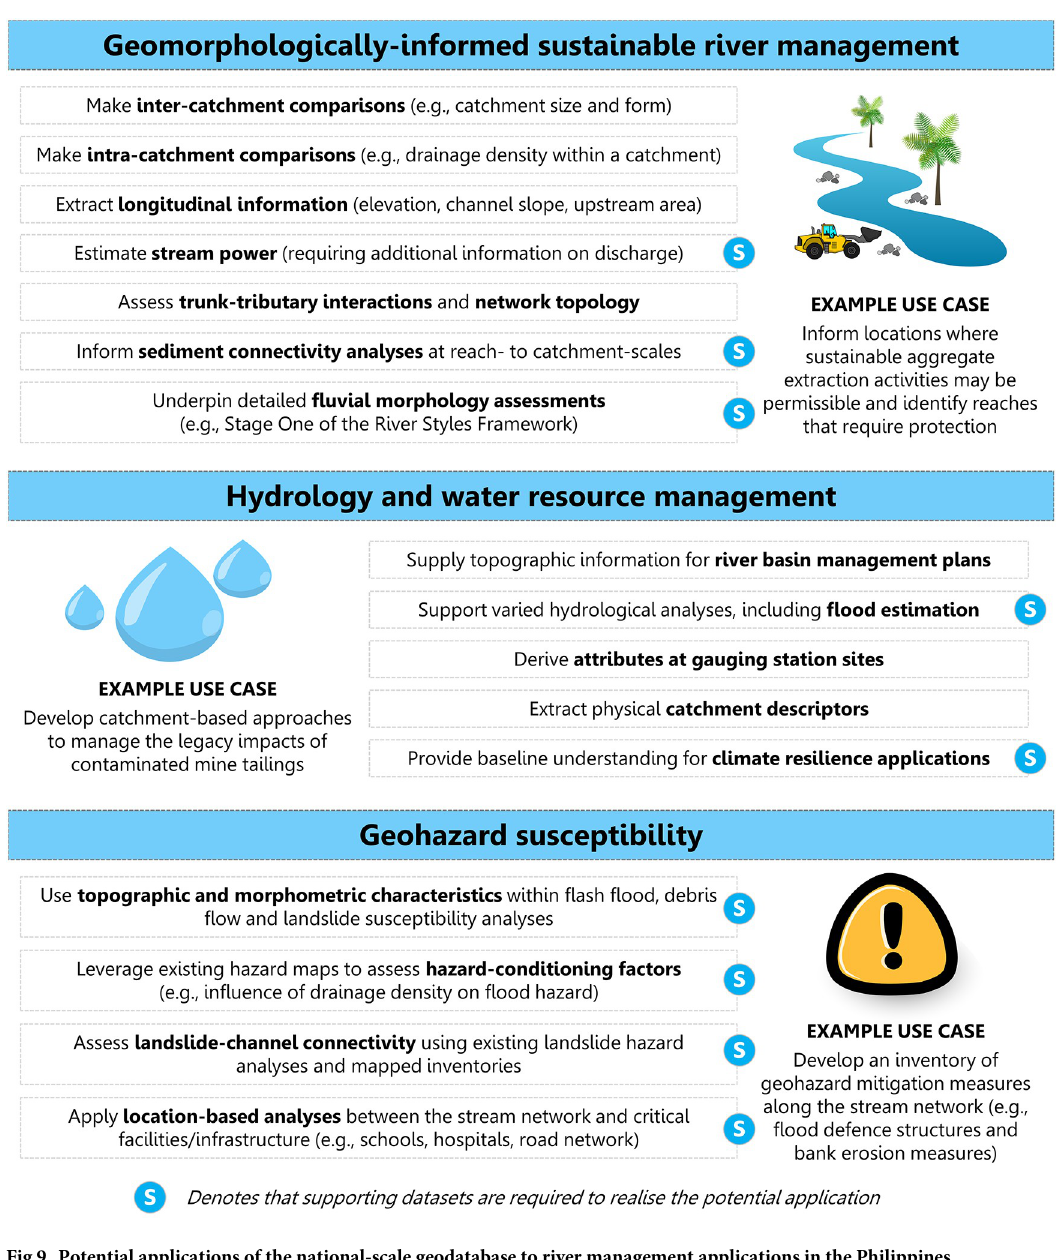
Fig 9. Potential applications of the national-scale geodatabase to river management applications in the